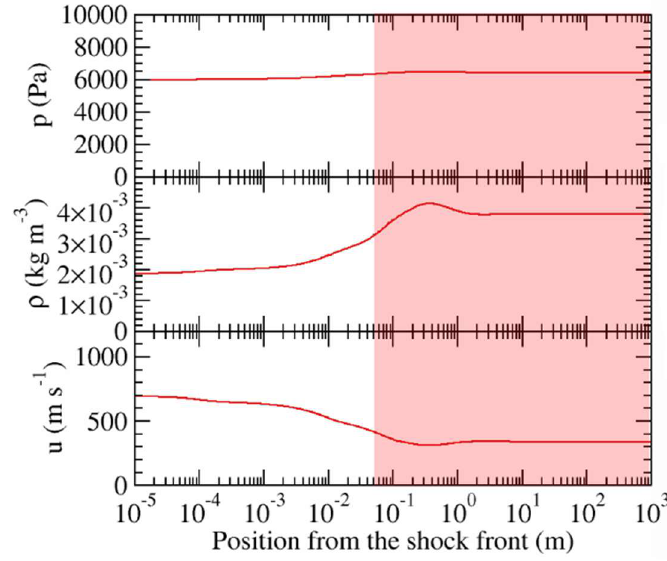
Figure 2. Post-shock relaxation for the pressure, the mass density and the speed resulting from Equations (3)–(6). Since the diffusion phenomena are assumed negligible in these equations, the solution corresponds to the real flow before 𝑥 = 𝛿 ≈ 5 𝑐𝑚 .